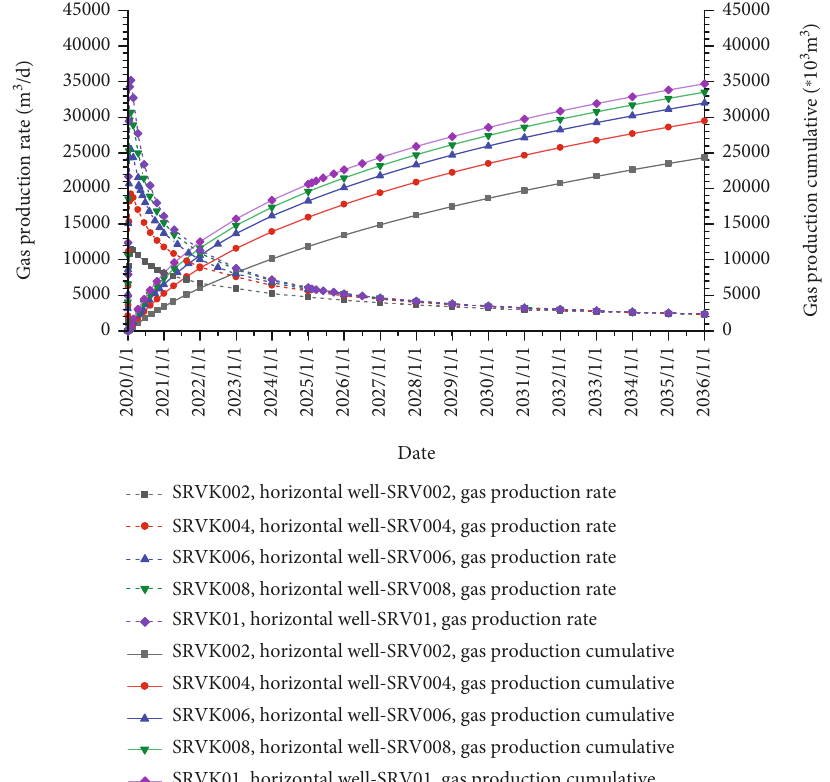
Figure 5: Production curves showing that horizontal well gas production under di ff erent SRV permeability is greater than that of cumulative gas